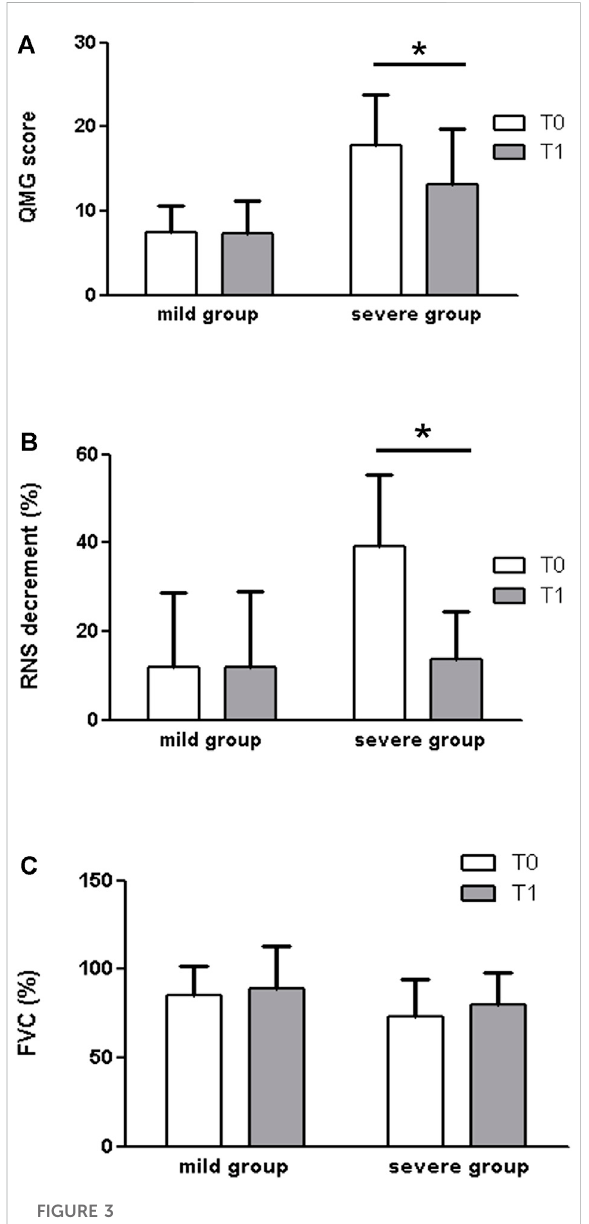
FIGURE 3 When we divided patients by grouping milder (MGFA classes IIaandIIb, n =9)andmoresevere(MGFAclassesIII-IV, n =6)forms of disease, what emerged is that 3,4-DAP showed a positive effect in the severe group, by measures of the QMG score (A) (T0: 17.83 ± 6.01; T1: 13.17 ± 6.58. p = 0.031), the RNS decrement (B) (T0: 39.25 ± 16.25; T1: 13.67 ± 10.71. p = 0.031), and a trend towards signi fi cance for the FVC (C) (T0: 73 ± 21.14; T1: 80 ± 17.83 p = 0.063). No signi fi cant difference was observed in any of the outcome measures within the mild group ( p > 0.05).